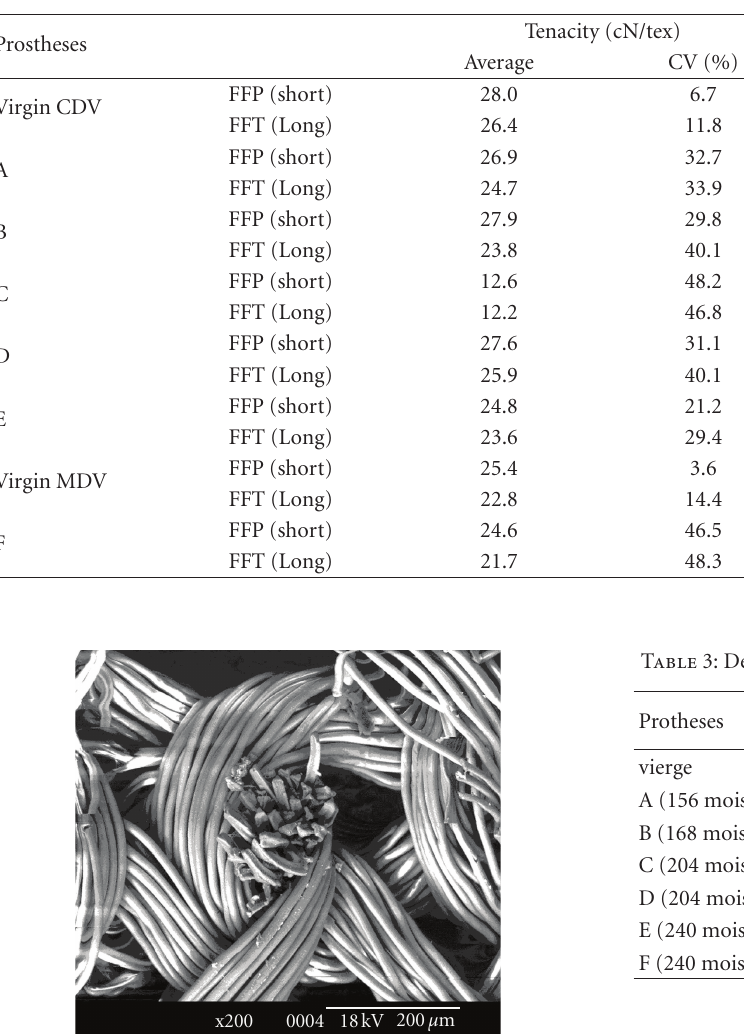
Table 2: Results of the filament dynamometry performed on short and long filaments of the specimens. Prosthesis number is the reference number given in the first clinical description of the series. (CDV: Cooley Double Velour; MDV: Microvel Double Velour; CV: coe ffi cient of variation).